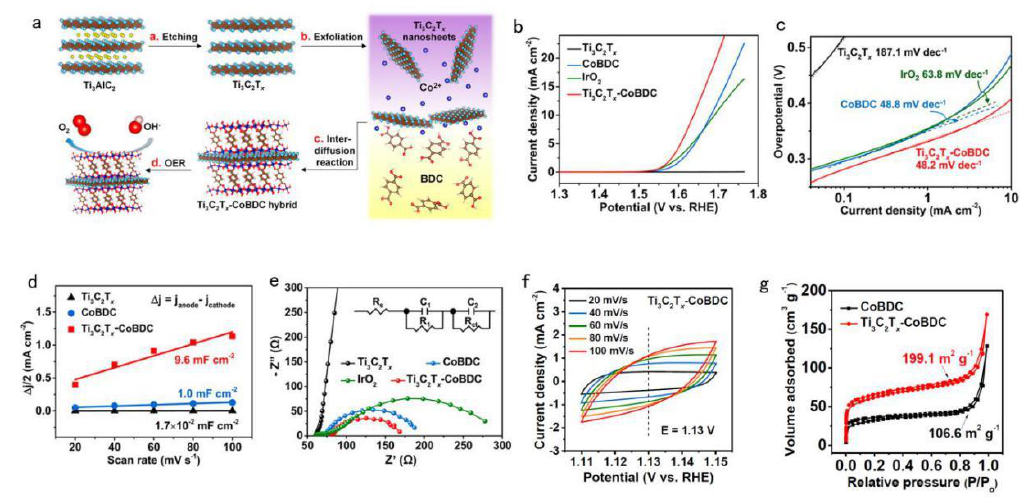
Figure 13. ( a ) Illustration of the hybridization procedures of Ti 3 C 2 MXene nanosheets and a cobalt 1,4-benzenedicarboxylate (CoBDC) MOF. ( b ) LSV curves, ( c ) Tafel plots, and ( d ) C dl of CoBDC, Ti 3 C 2 T x , and Ti 3 C 2 T x –CoBDC hybrid. ( e ) Nyquist plots (EIS) of CoBDC, Ti 3 C 2 T x , Ti 3 C 2 T x –CoBDC hybrid, and IrO 2 . ( f ) CV curves of Ti 3 C 2 T x –CoBDC hybrid at a scan rate of 20 to 100 mV / s at a potential range of 1.11 to 1.15 V vs. RHE without obvious Faradaic process. ( g ) The specific surface area of Ti 3 C 2 T x –CoBDC hybrid. Reproduced with permission from [41]. Copyright 2017 American Chemical Society Nano